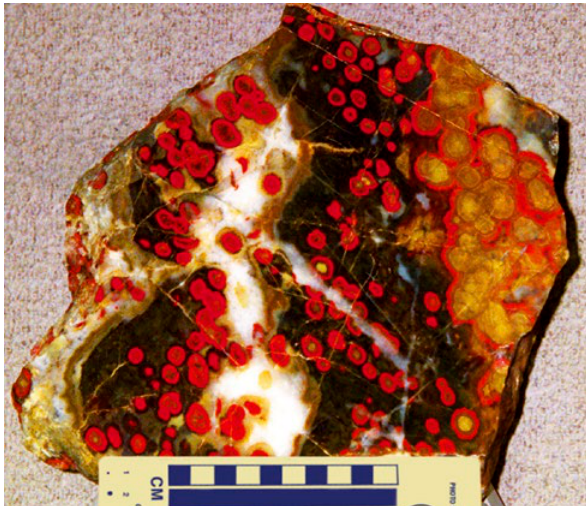
Figure 64. Later diagenetic colloidal silica branching into veinlets, fills syneresis cavities in an oolitic jasper lode. Earlier khaki chert rims the syneresis cavities in a similar manner to its occurrence in geodes and it fills veinlets which cut the soft precursor oolites. The jaspers, the chert, and the oolites undeniably indicate precursor silica gel. This Smithsonian Institute specimen is from near Gilroy, California,